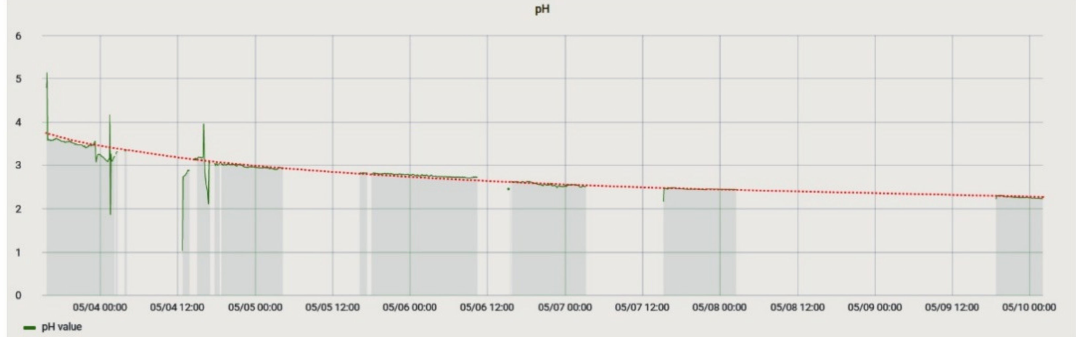
Figure 18. pH change during the experiment to determine the aging of the solution. The red line is an exponential trend line that can describe the